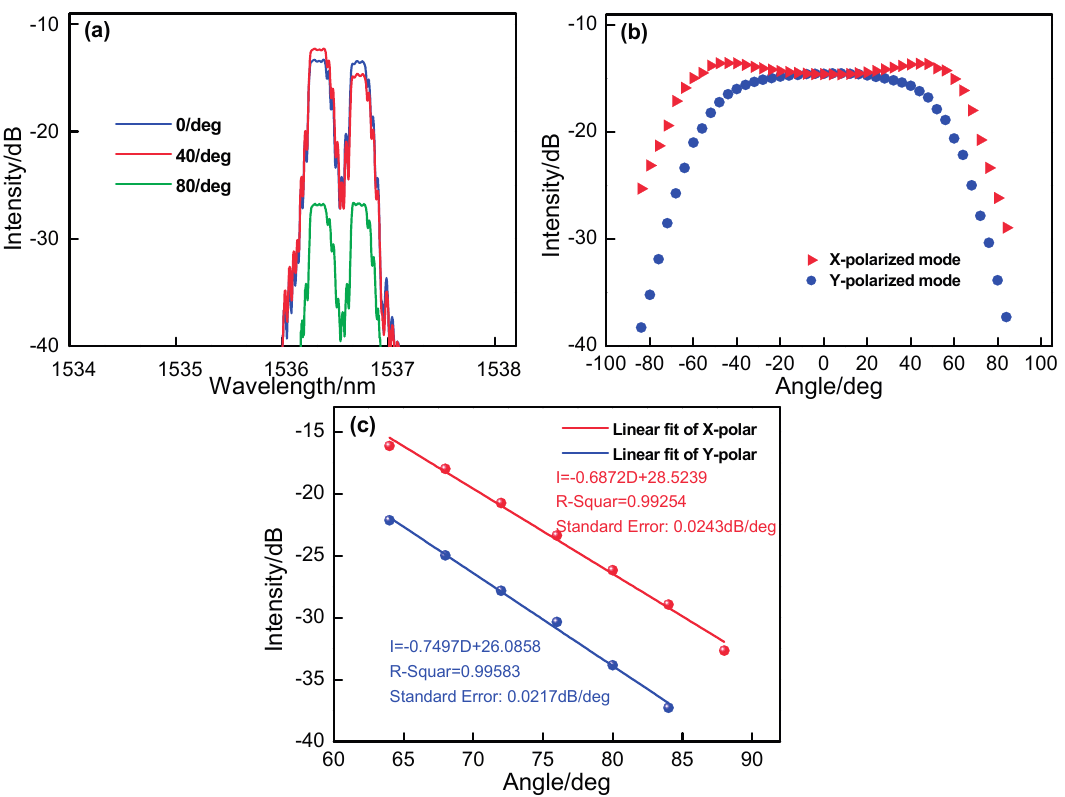
Figure 3. ( a ) Change of coupling intensity the LP01( x ) and LP01( y ) modes with the different bending angle; ( b ) intensities of x - and y -polarized modes act as the function of the bending angle; ( c ) linear fit of intensity of the x - and y -polarized mode changes with the bending angle at the range from 64° to